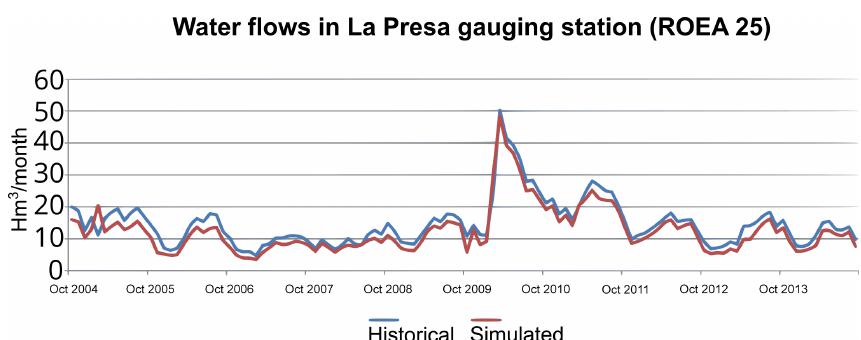
Figure 3. Comparison of water flows observed in La Presa and simulated by the model.